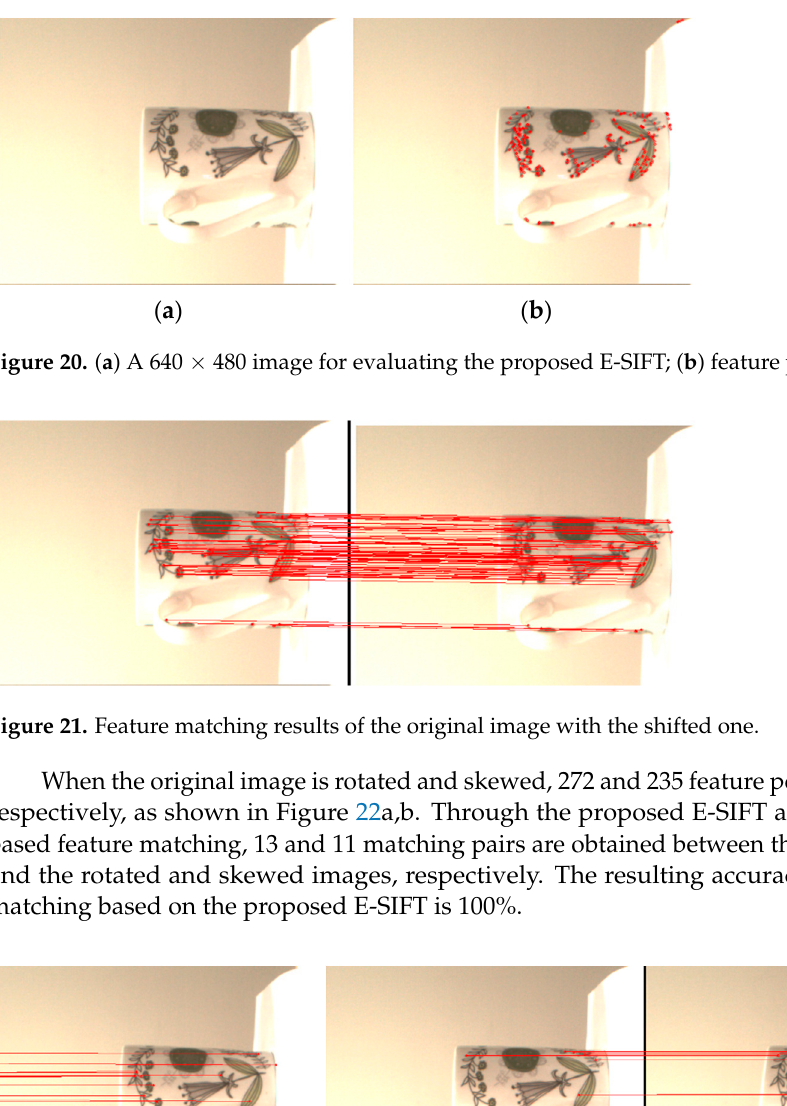
Figure 22. Feature matching results of the original image with ( a ) the rotated and ( b ) the skewed image.